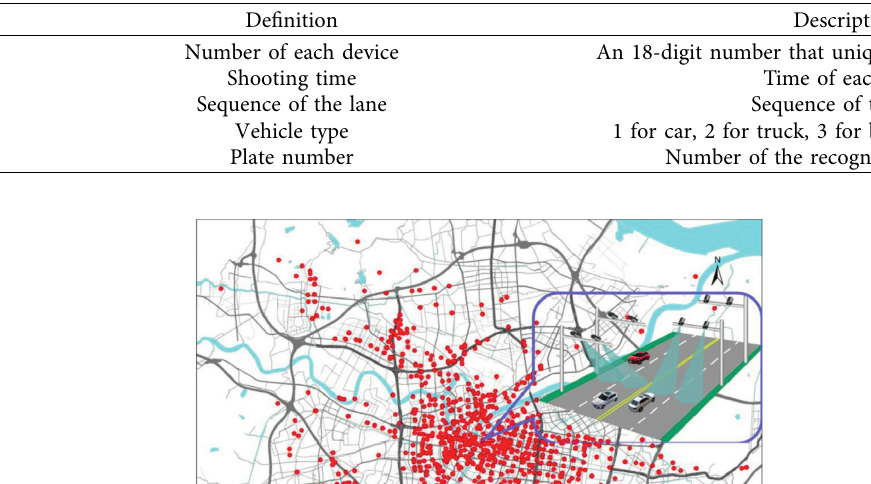
Table 1: Data description of license plate captured by bayonet.